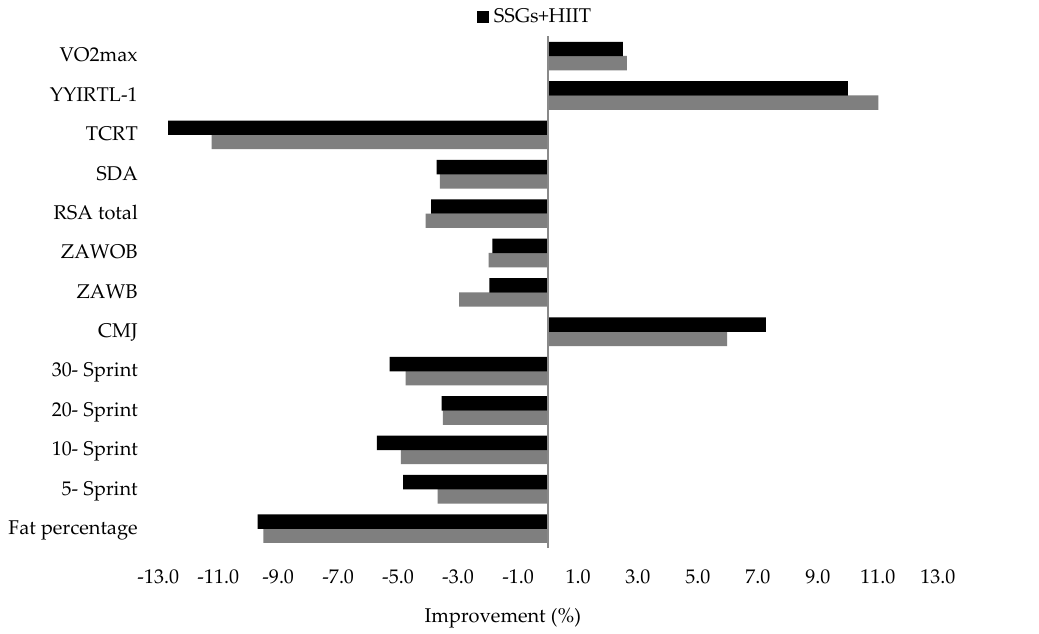
Figure 1. Improvement in body composition, physical and technical performance responses following the combined training interventions.